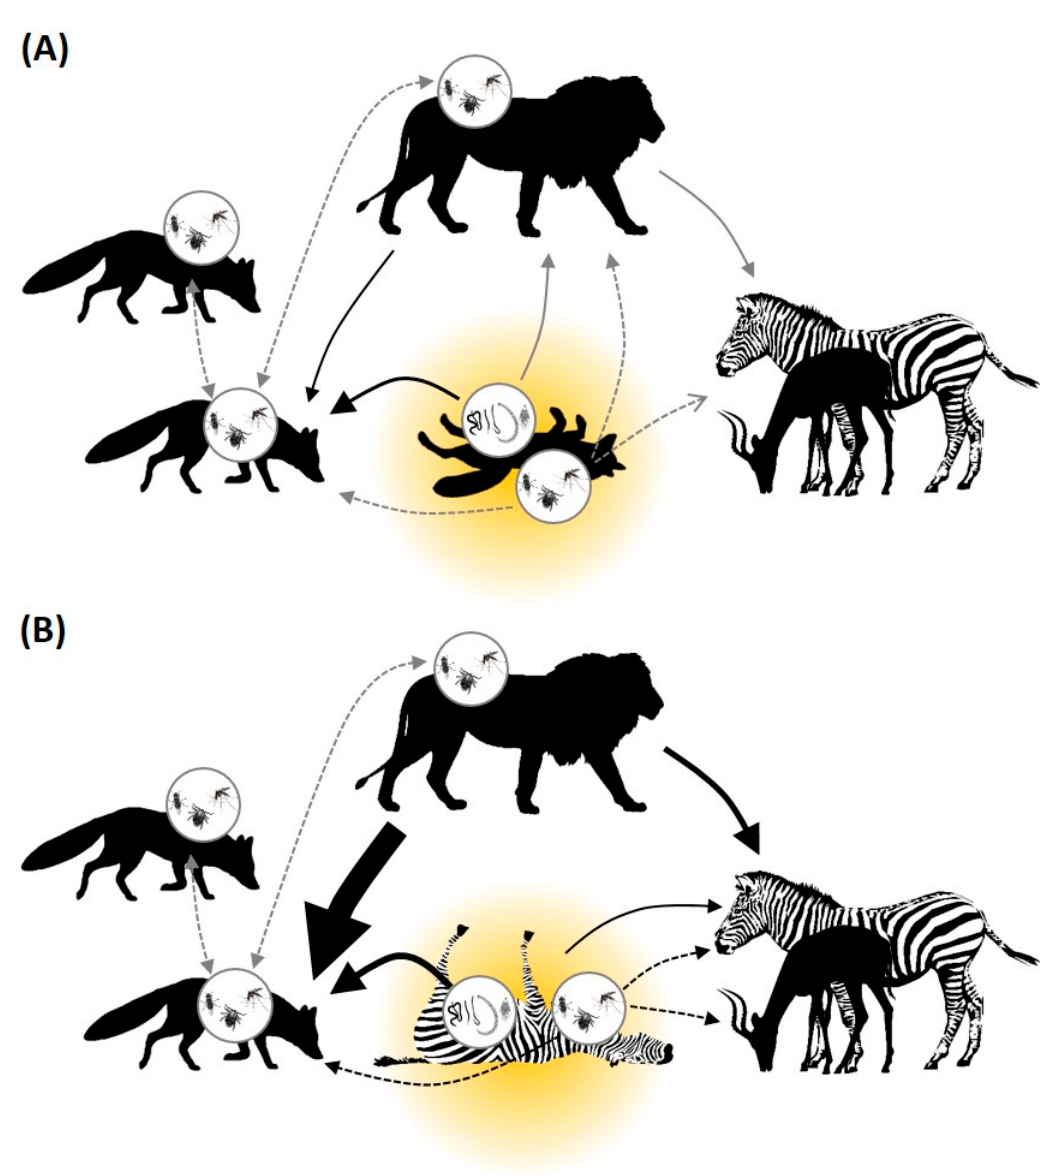
Figure 3. Research effort devoted to the main fear- and disgust-related interaction pathways around ( A ) carnivore and ( B ) herbivore carrion, according to our literature review. Those pathways for which we found at least one article are shown by black arrows (we use grey arrows otherwise). Arrow width is proportional to the number of articles.